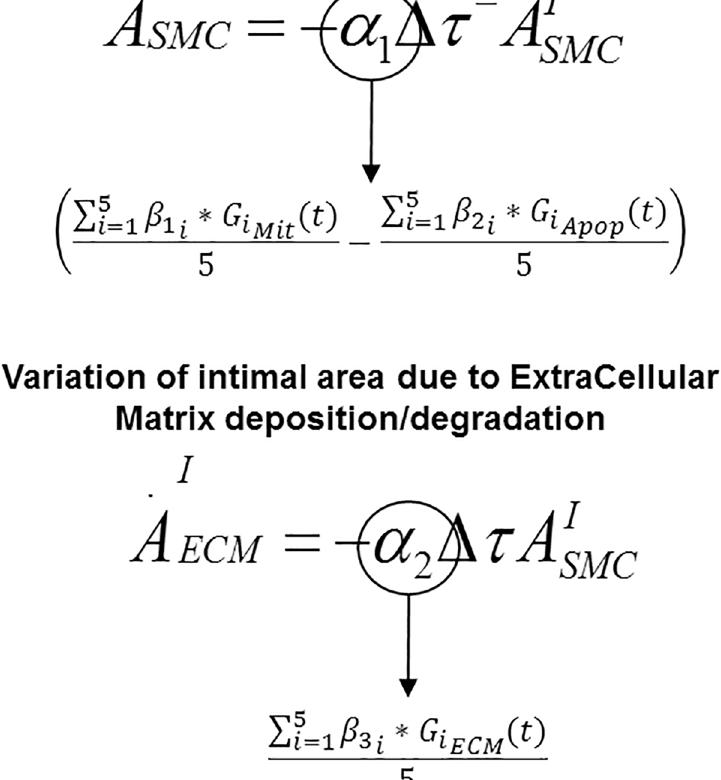
Fig 5. Sub-models coupling. Constant parameters α 1 and α 2 are replacedby the time dependent cluster dynamics mappedto the correspondent biologicevent.